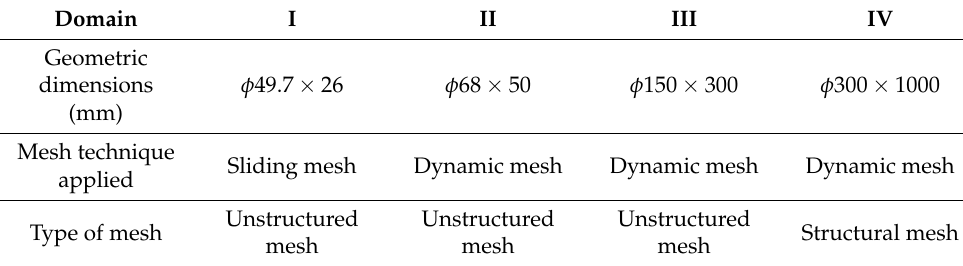
Table 2. Fundamental parameters and techniques applied in the four domains.